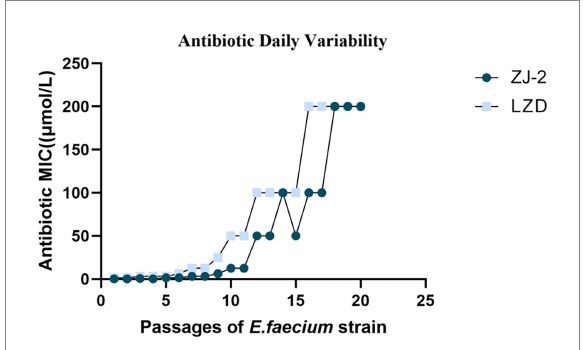
FIGURE 5 Broth dilution serial passage resistance induction studies. Average daily MIC during exposure of E. faecium E3101 to sub-MIC concentrations of linezolid over 22 days of bacterial growth.